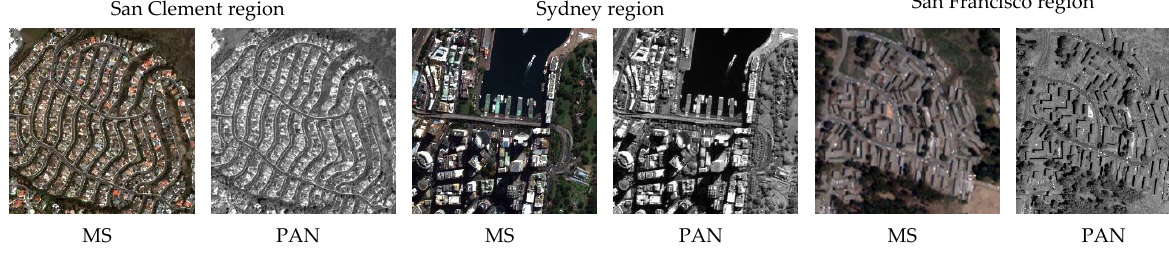
Figure 2. MS and PAN data sets.